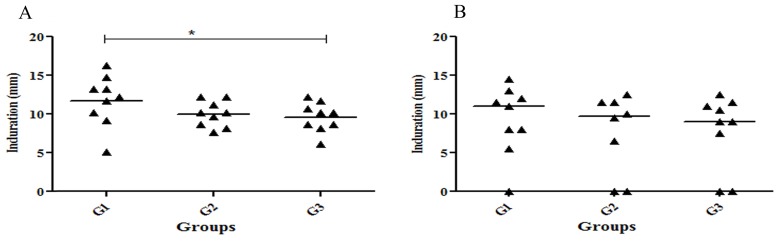
Size of induration after injection of L. infantum stationary phase promastigotes in 0.4% phenol-saline to measure skin test reactivity.Data represent the individual delayed type of hypersensitivity responses in millimeter at months11 (A) and 16 (B) after infection. DTH reaction was determined by injecting intradermally in the inner aspect of the right hind leg with 0.1 ml of L. infantum in 0.4% phenol-saline antigen (3×108 stationary phase promastigotes/ml). The left hind leg received only 0.1 ml 0.4% phenol saline solution. Data represent the increase of intradermal reaction performed 48 hrs after antigen injection. The values of the saline control were subtracted from the reaction due to the Leishmania antigen. Reactions ≥5mm were considered as positive.